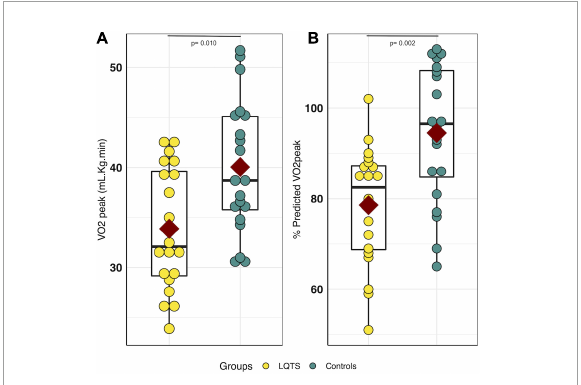
FIGURE2 VO 2peak comparison between LQTS and control groups. (A) VO 2peak comparison. (B) Percent-predicted VO 2peak comparison. For each group, the dark red square represents the mean value for each group, the black boxplot represents the first, second and third quartiles [e.g., Q1, median, Q3], respectively. LQTS, long QT